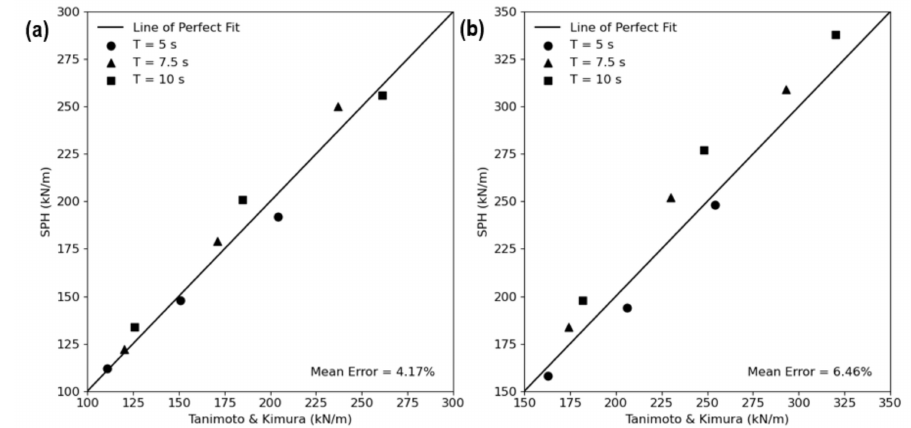
Figure 11. Comparison between empirical and SPH maximum wave forces on the sloped floodwall for ( a ) d w = 4 m and ( b ) d w = 5